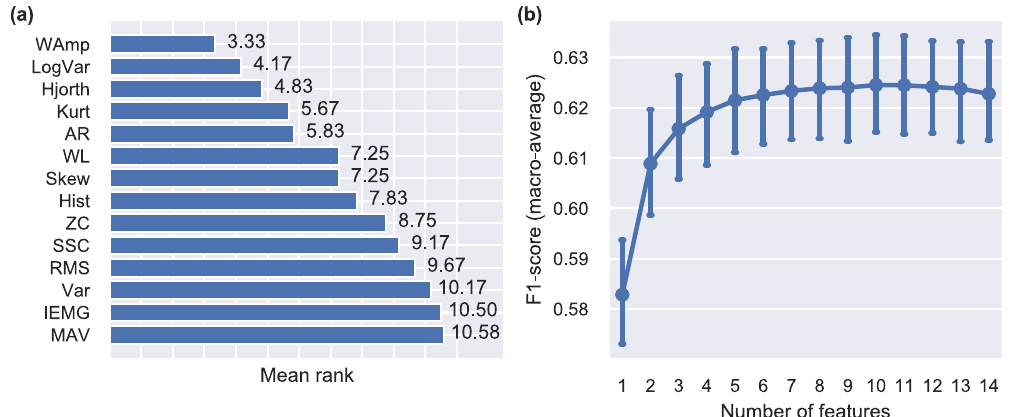
Figure 2. Feature analysis. ( a ) Average ranking for individual features using the sequential forward selection method. The procedure was run independently for each participant and average rankings were computed ( n = 12 ). Lower ranks indicate larger feature importance. ( b ) Performance as a function of the number of features used for decoding. Higher F1-scores indicate better performance. Points, means; error bars, standard errors estimated via bootstrapping (1000 iterations).